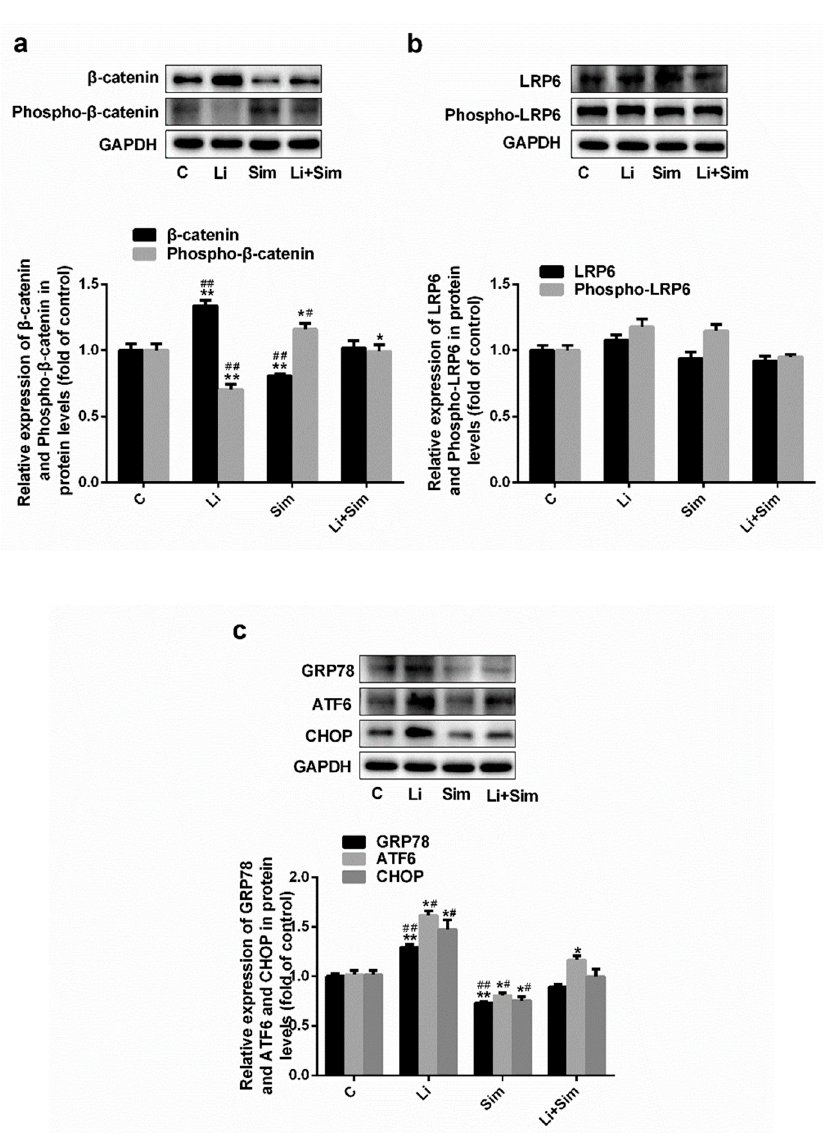
Figure 4. Simvastatin inhibits ER stress by inhibiting the Wnt / β -catenin pathway. The expressions of ( a ) β -catenin, phospho- β -catenin ( b ) LRP6, phospho-LRP6 ( c ) GRP78, ATF6 and CHOP in protein levels. * p < 0.05 or ** p < 0.001 versus C group; # p < 0.05 or ## p < 0.001 versus Li + Sim group, n = 3. C, HUVECs treated with H 2 O 2 ; Li, C group treated with LiCl; Sim, C group treated with simvastatin; Li + Sim, C group treated with simvastatin and LiCl.